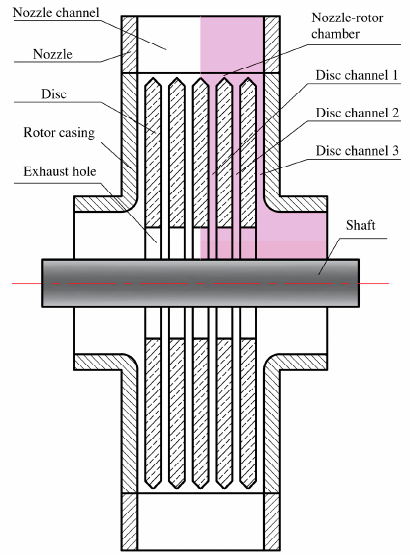
Figure 3. Schematic diagram of the one-to-many Tesla turbine with sharp disc tips.